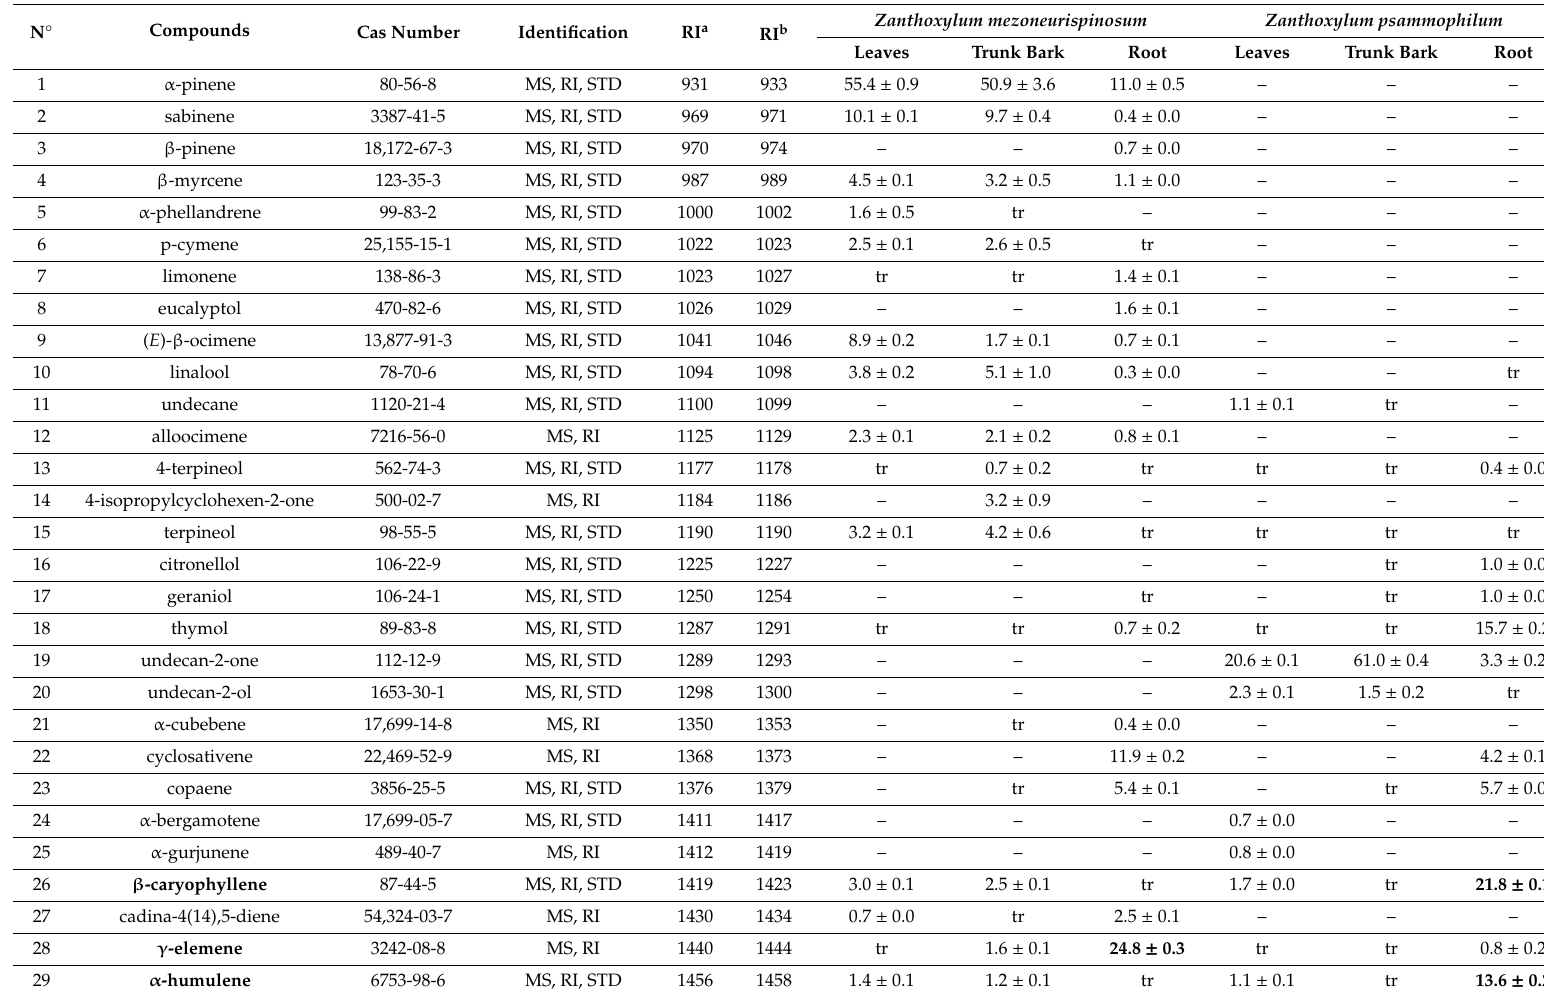
Table 1. The chemical composition of essential oils isolated from di ff erent organs of two Zanthoxylum species endemic to C ô te d’Ivoire. Data are expressed as the mean of